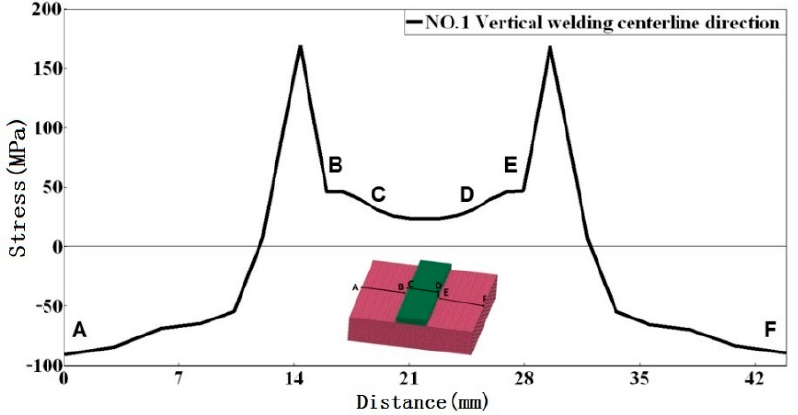
Figure 14. The residual stress distribution curve in the direction perpendicular to the centerline of the surfacing welding.